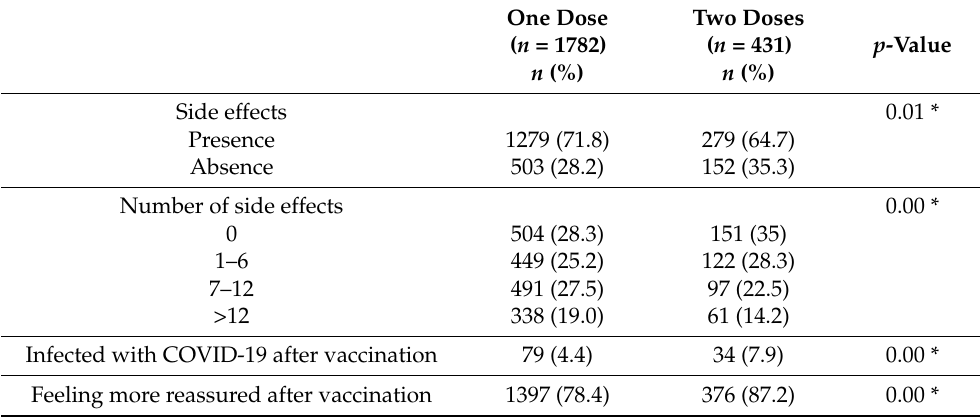
Table 4. Association of the side effects with the possibility of COVID-19 infection after receiving both doses.